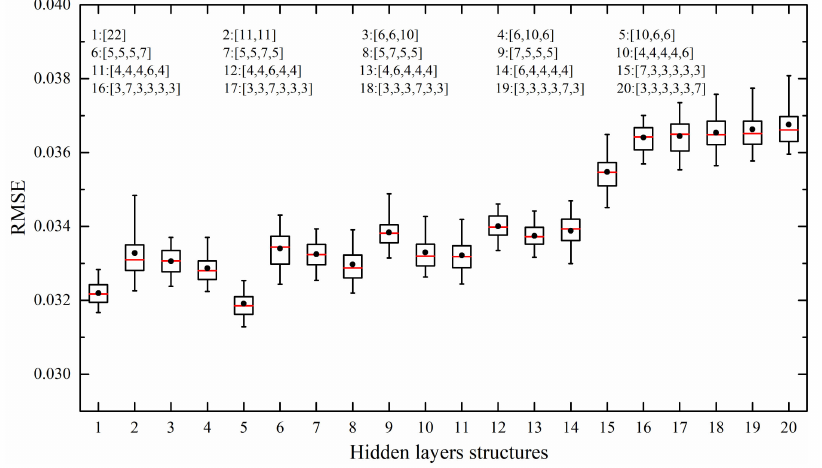
Figure 5. Prediction RMSEs for different hidden layer structures (neural network model for May).